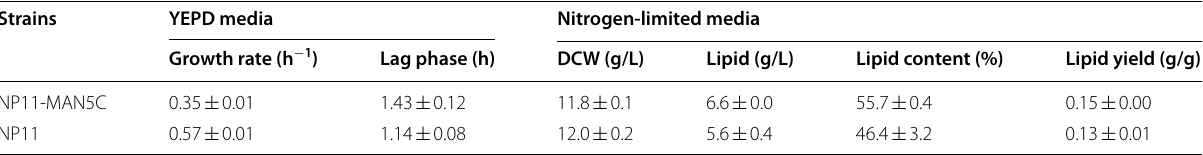
Table 2 Results of cell cultures in different media